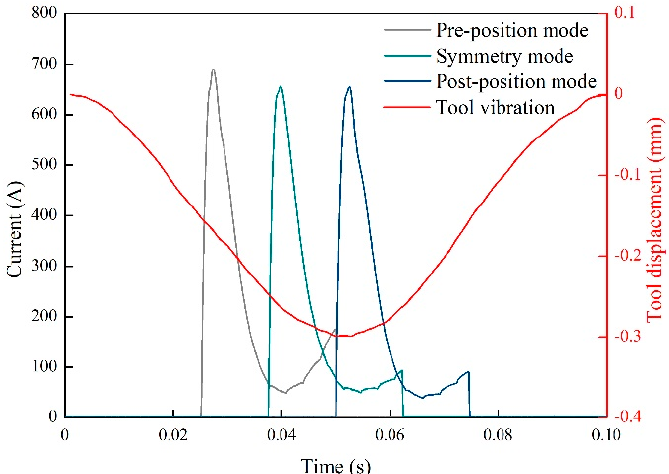
Figure 11. Instantaneous current as a function of time for the three coupling modes at the end of machining and with the highest feed rate.